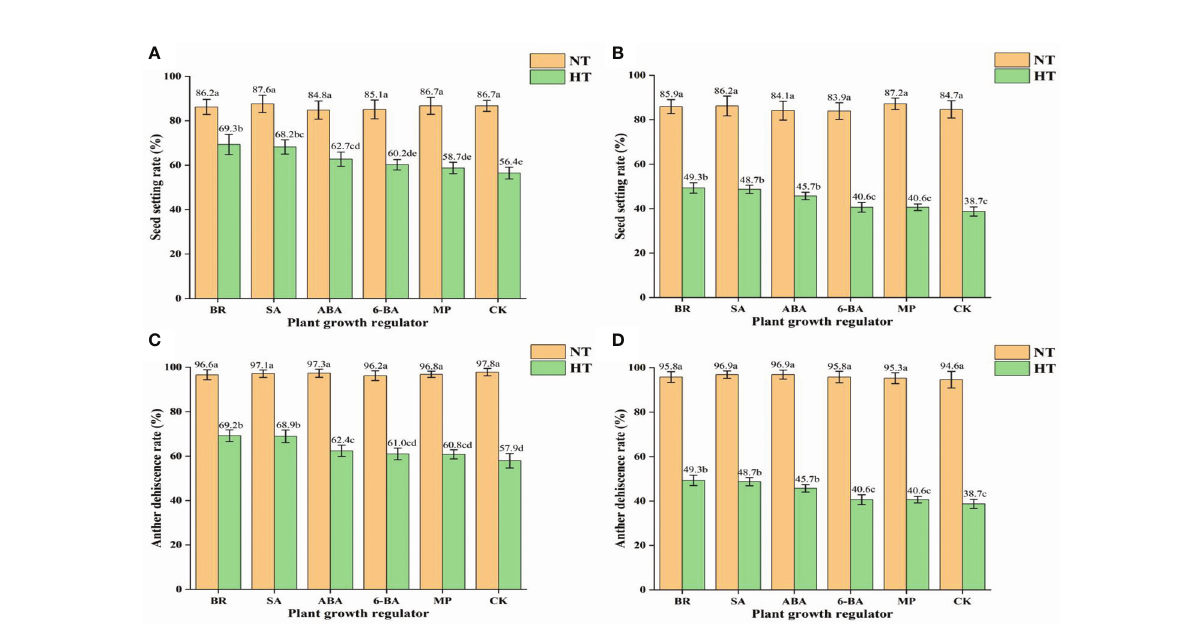
FIGURE 5 Effects of plant growth regulators on seed set and anther dehiscence of two rice cultivars under different temperature treatments. (A) Seed set of Huanghuazhan (HHZ). (B) Seed set of Huiliangyou 858 (HLY858). (C) Anther dehiscence of HHZ. (D) Anther dehiscence of HKY858. Bars with different lowercase letters indicate a signi fi cant difference (LSD test, p < 0.05). Error bars indicate the SD of three biological replicates. HT, high temperature; NT, normal temperature. BR, brassinolide; SA, salicylic acid; ABA, abscisic acid; 6-BA, benzylaminopurine; MP, potassium dihydrogen phosphate; CK,